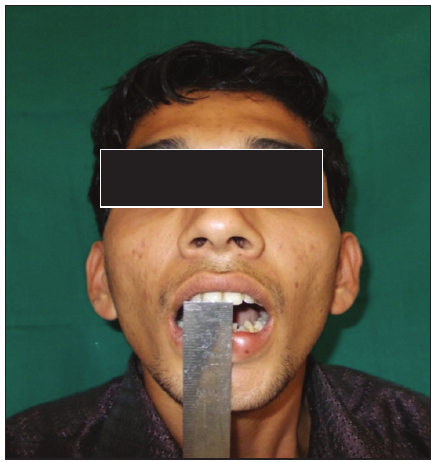
Figure 1: Preoperative mouth opening.